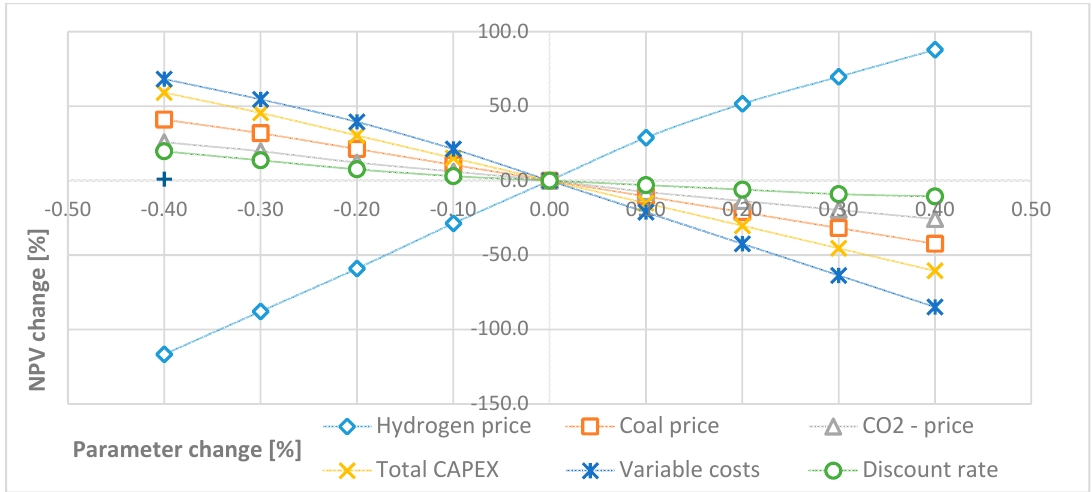
13 of 19 Figure 4. Sensitivity analysis for coal gasification w/ CCS unit (HC_H2_1). Source: own study. Table 11. Sensitivity analysis for lignite gasification w/o CCS (L_H2_0). Item